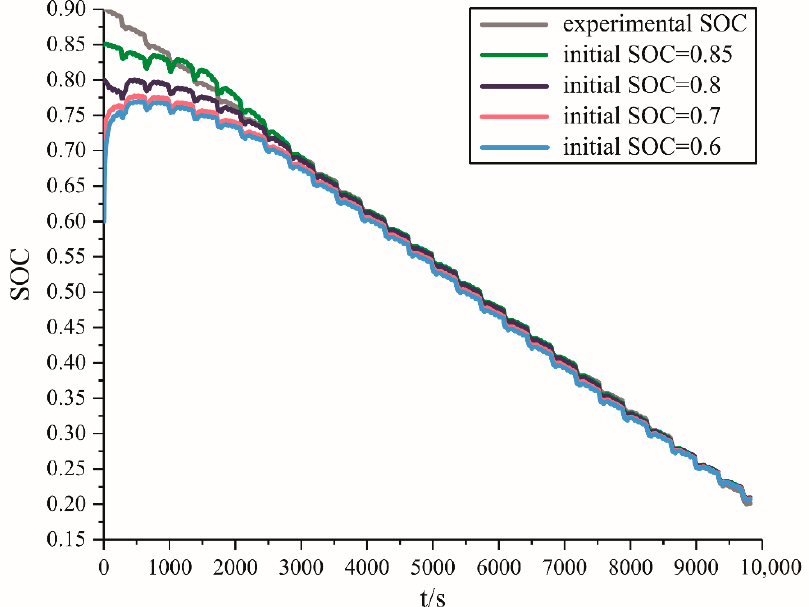
Figure 21. Comparison of SOC filtered by FEKF in different SOC initial errors under 26 continuous DST conditions at 28 °C.